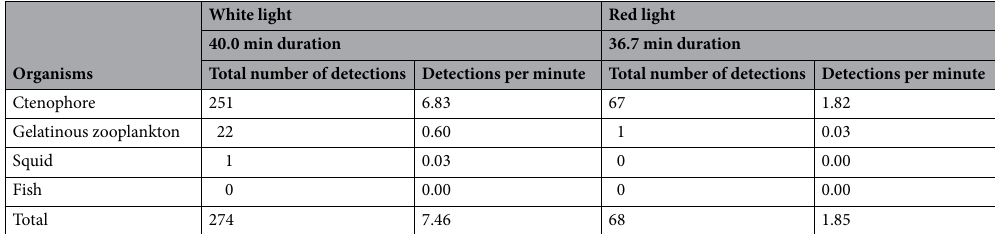
Table 2. Number of organisms detected by the baited camera equipped with a white or red light during the Newfoundland survey. Note that swarms of copepods were also detected but individual copepods could not be